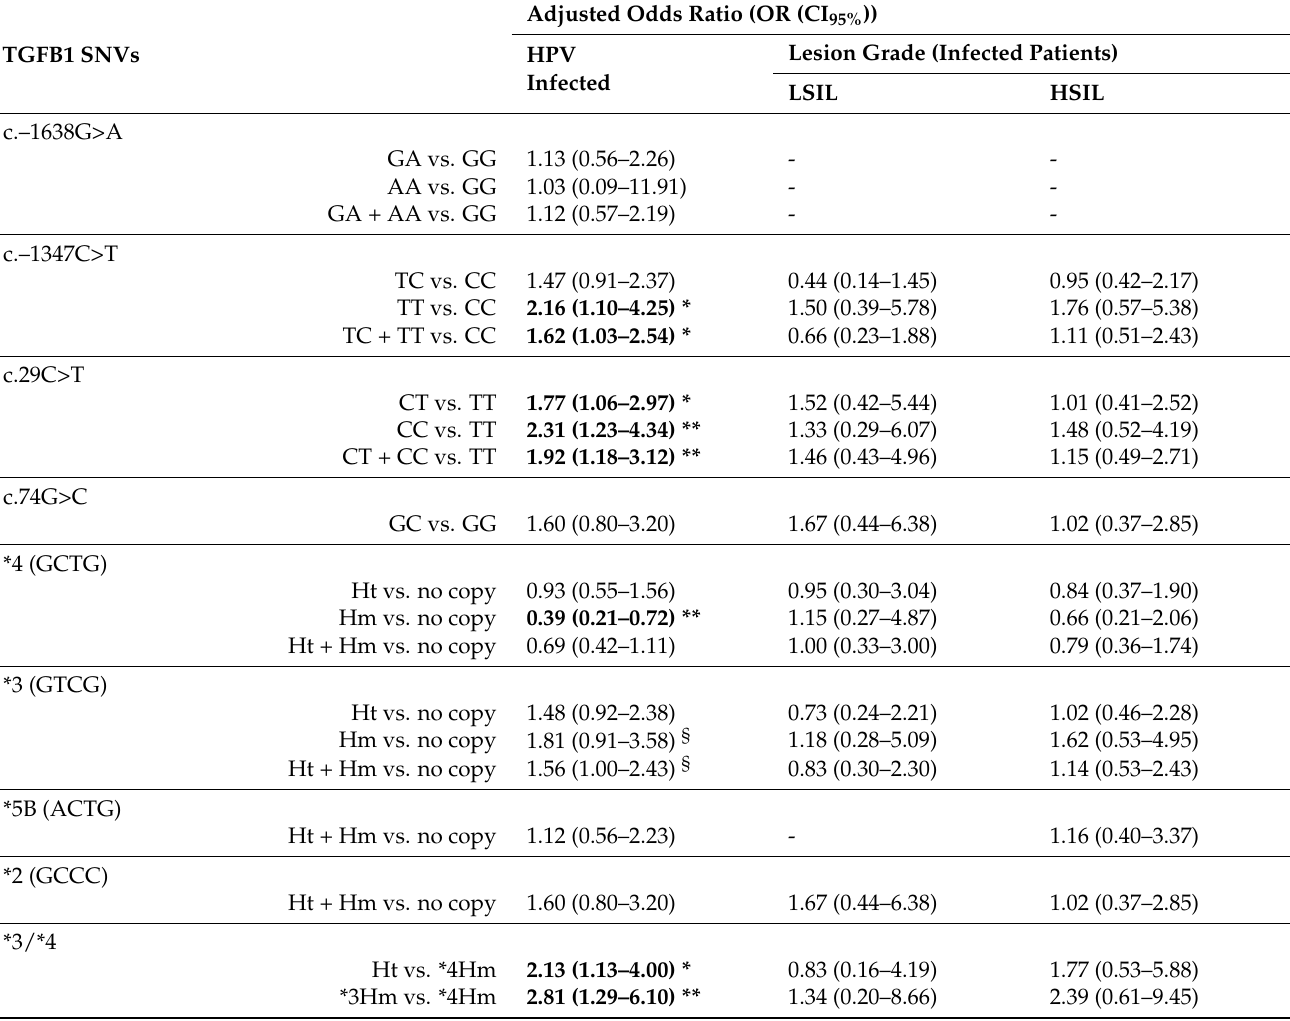
Table 4. Susceptibility for HPV infection, LSIL, and HSIL according to TGFB1 genetic